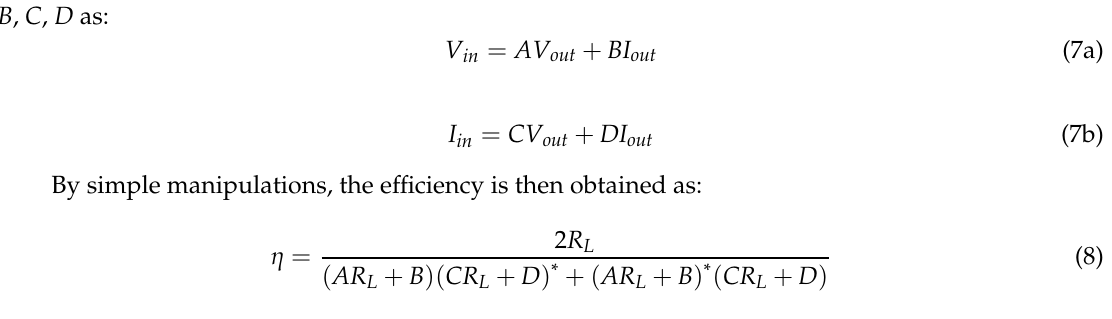
topologies. Equivalent two-port network model ( c ).